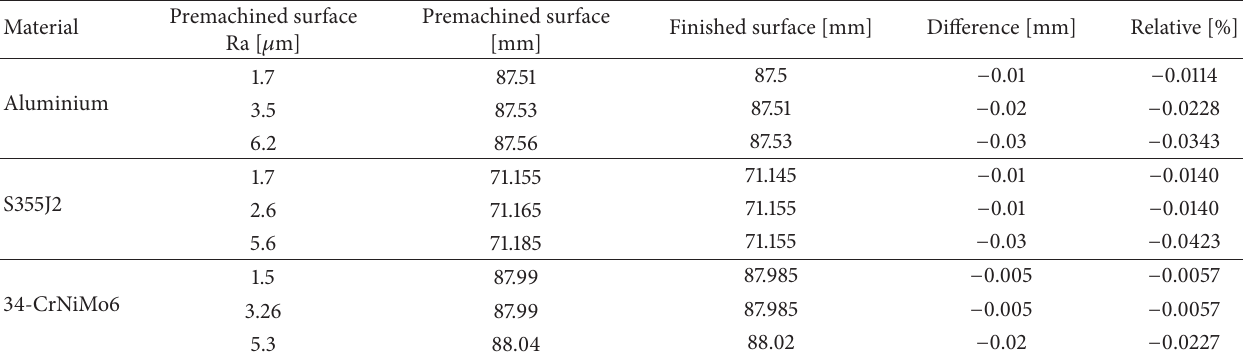
Table 5: Diameter